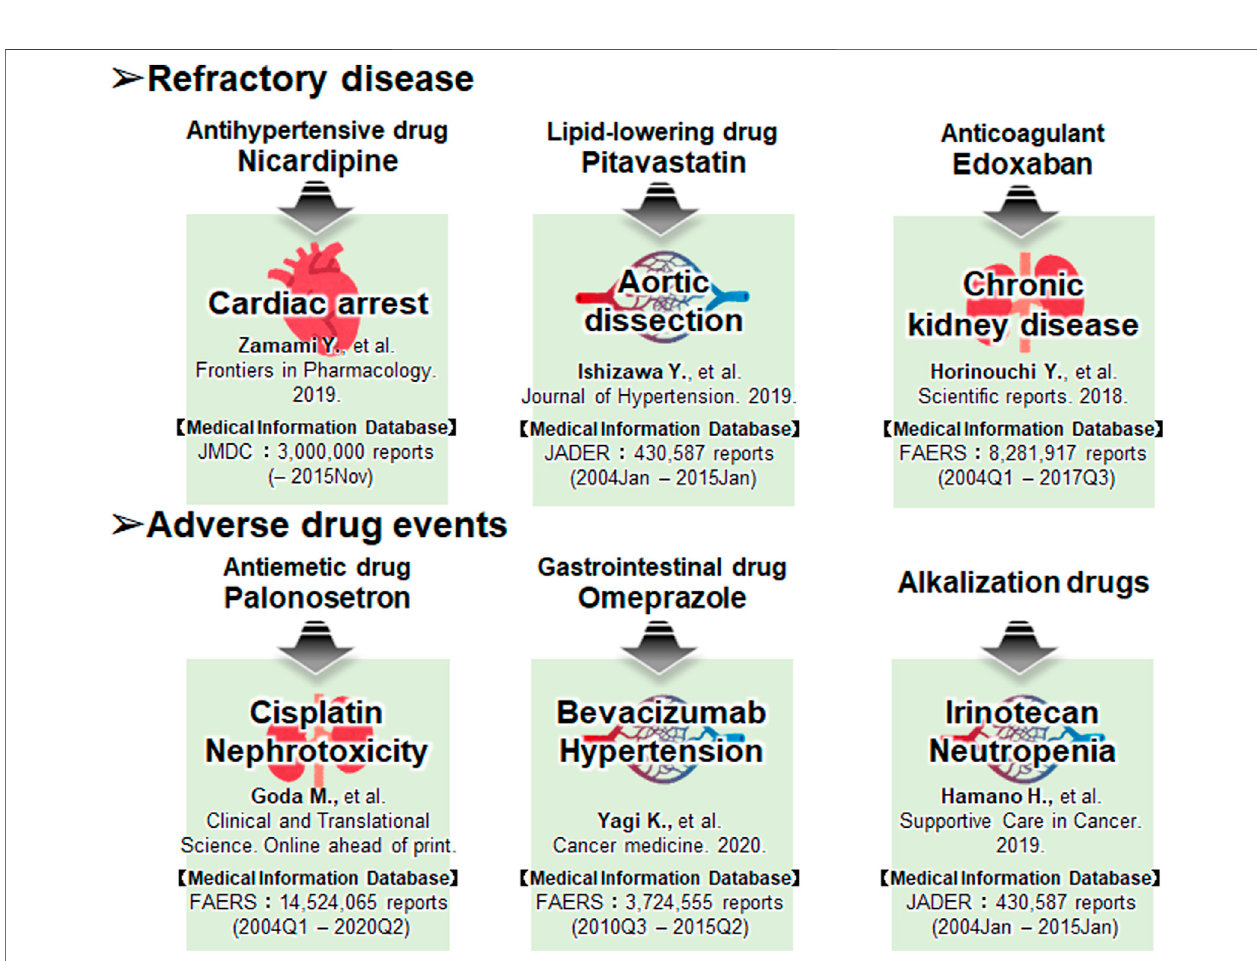
FIGURE 3 | The drug repositioning studies conducted by our research group using the databases. Our future work focuses on developing drugs that have preventive effects against largely intractable diseases and assessing their side effects.